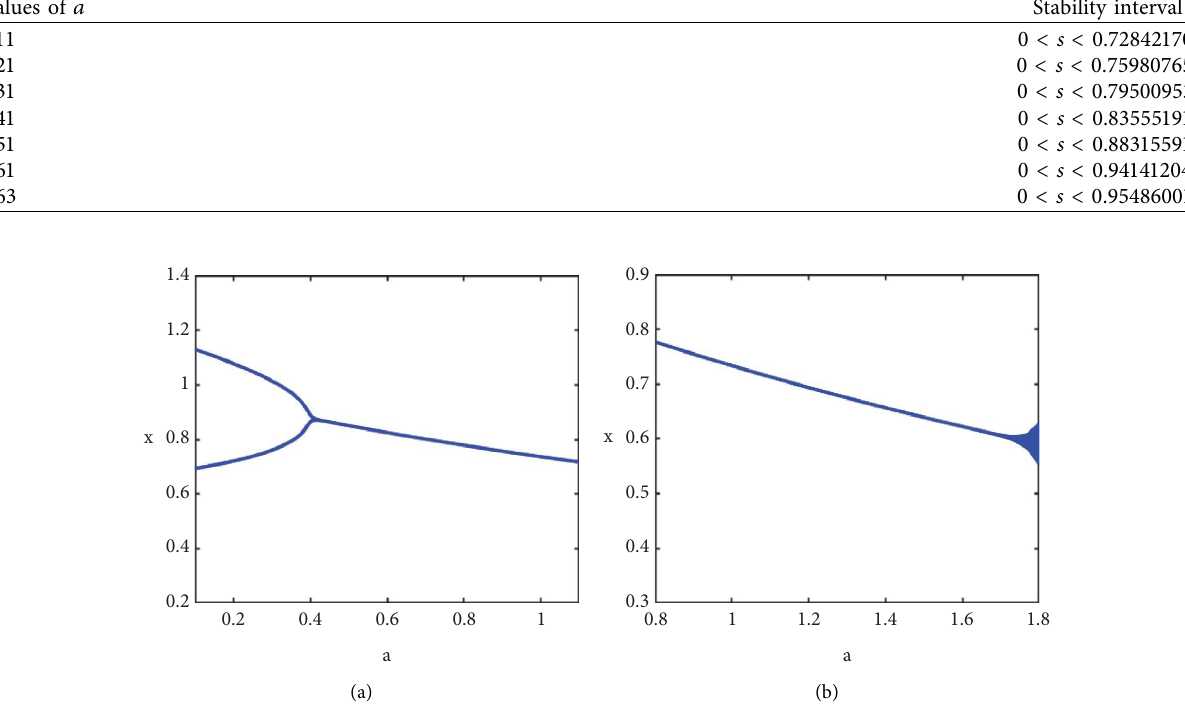
Figure 16: (a) Bifurcation diagram for the controlled model (120) when s � 0 . 83. (b) Bifurcation diagram for controlled model (121) when s � 0 . 94. Table 2: Controllable interval for model (115) with various values of a .